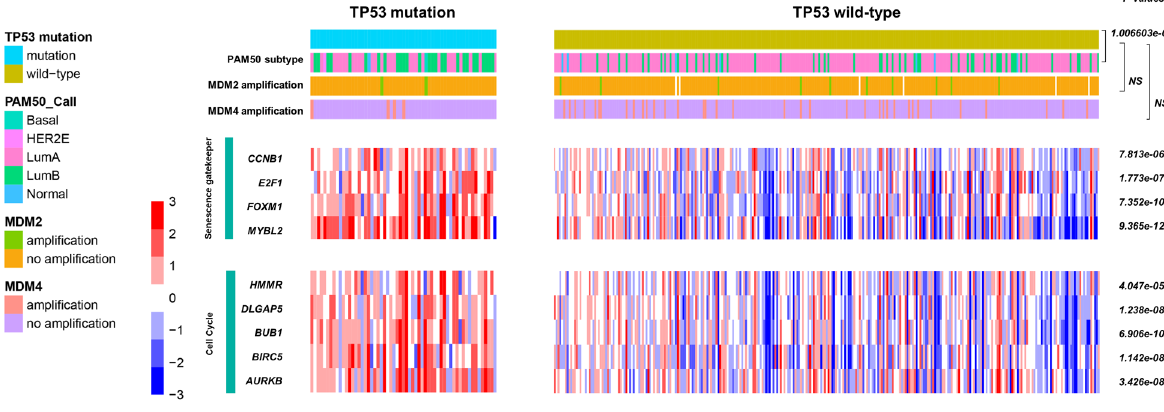
Fig. 5 PAM50 subtypes, MDM2/4 ampli fi cation, and TP53 -associated gene expression based on TP53 mutation in 356 ER + /PR + /HER2 − samples in TCGA ( n = 365). PAM50 subtype distribution, MDM2/4 ampli fi cation, and mRNA expression according with TP53 mutation were compared. The p -values were obtained using χ 2 tests, Fisher ’ s exact tests, and Student ’ s t-tests,